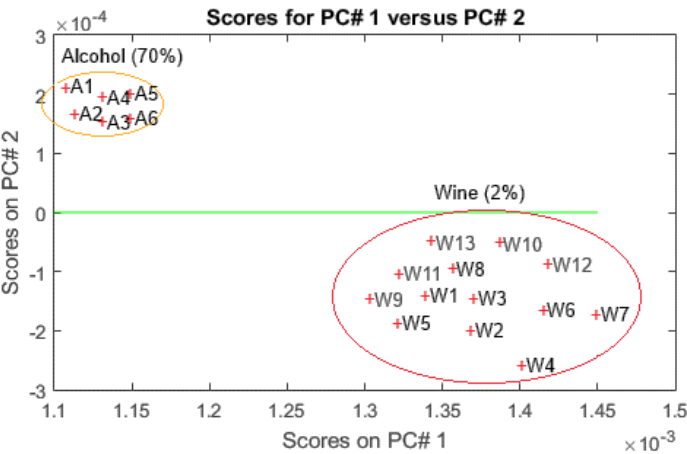
Figure 13. PCA scores plot performed to discriminate the measurements of alcohol (70%) and wine (2%) with temperature modulation.